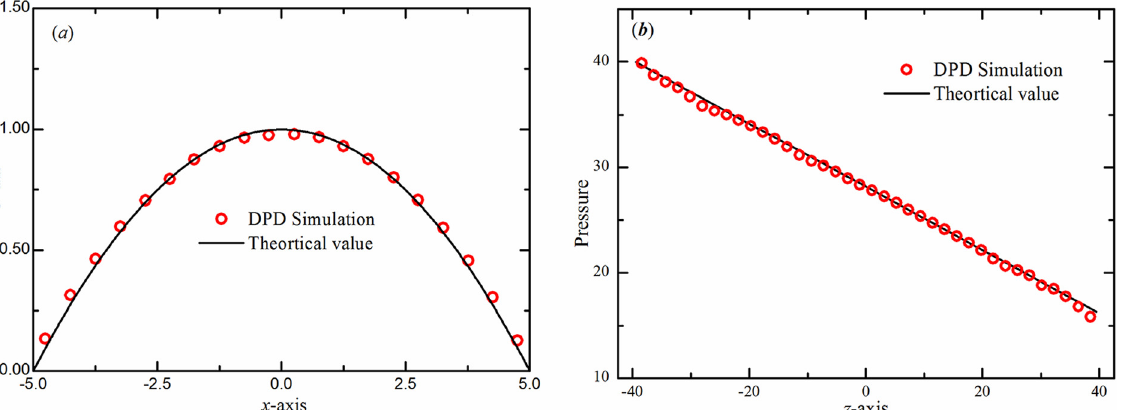
Fig 3. Verification of the accuracy of the proposed method. ( a ) Velocity profiles in the cross-flow ( x -axis) direction of the Poiseuille flow corresponding to open boundary conditions. The incompressible Navier-Stokes solution is shown with lines. ( b ) Pressure profile for the Poiseuille flow along the flow ( z -axis) direction. The symbols represent the DPD simulation results and the solid line represents the analytical